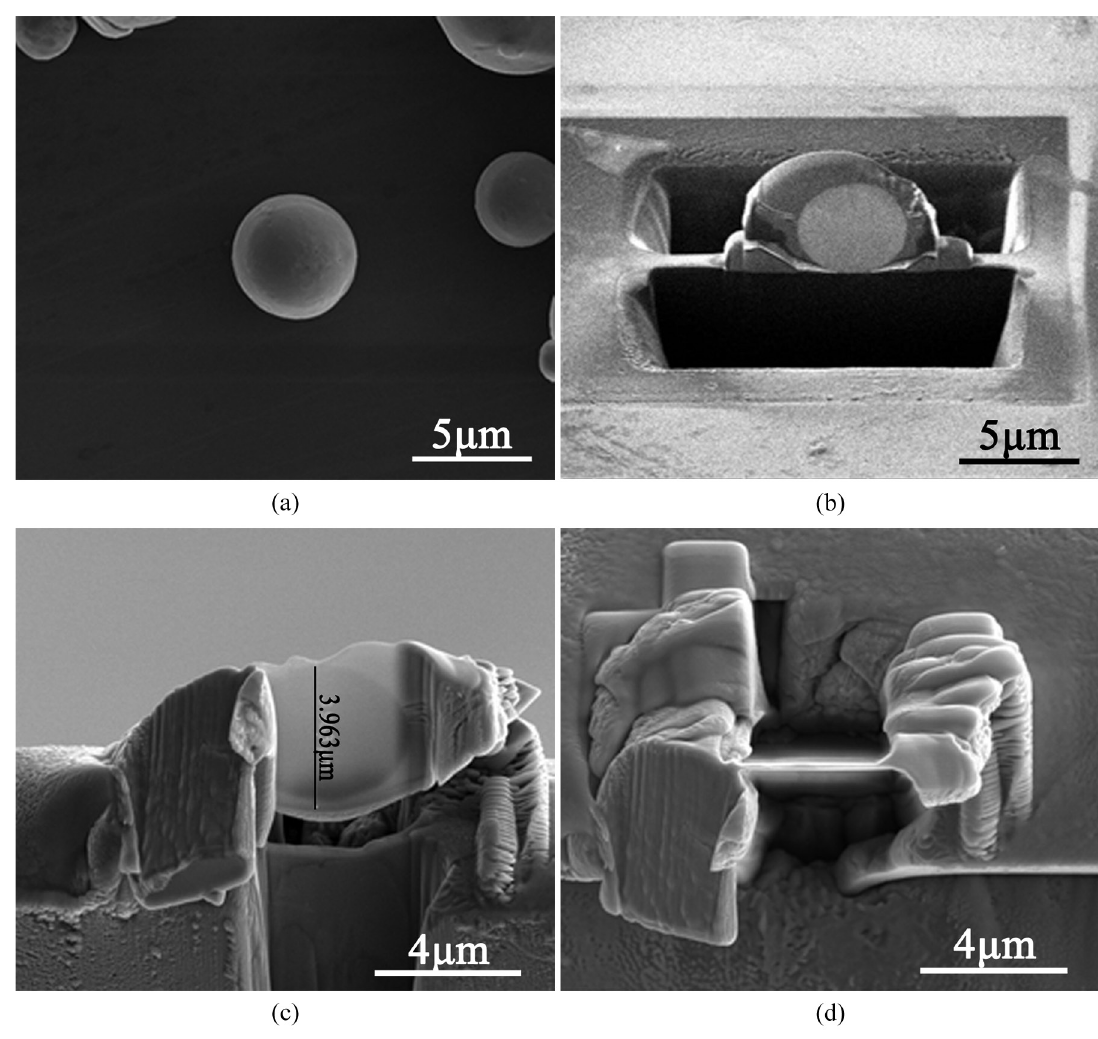
Figure 1. The process of specimens for TEM using FIB. (a) selected powder; (b) initial laminar specimen picked out from the powder; view of thin foils which is (c) perpendicular (d) parallel to the ion beam